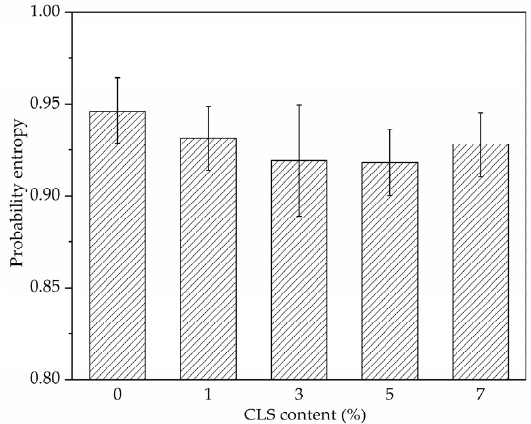
Figure 15. Probability entropy of improved loess with different CLS content.